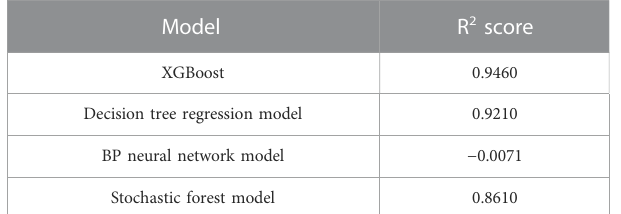
TABLE 8 Model score